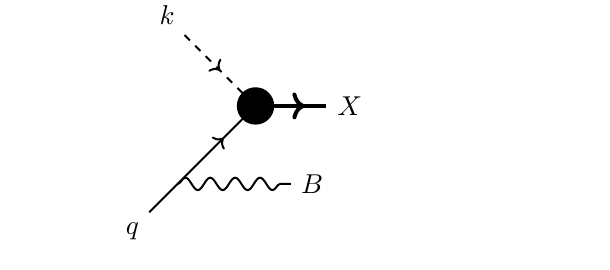
Figure 9 . Feynman diagram corresponding to real radiation of a dark